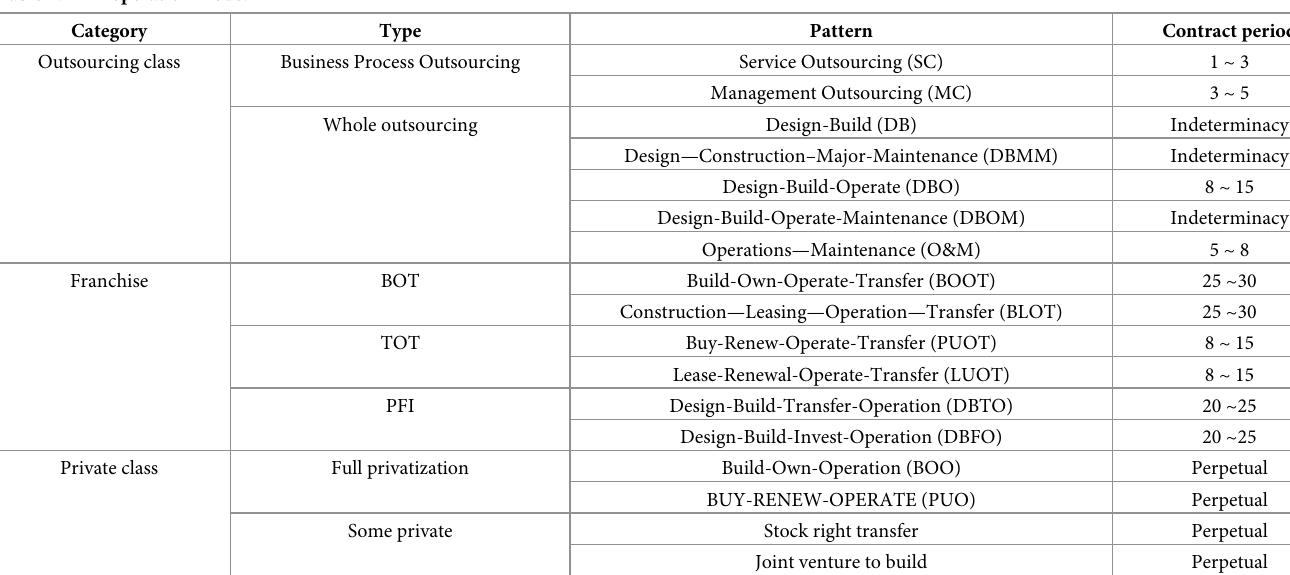
Table 1. PPP operation